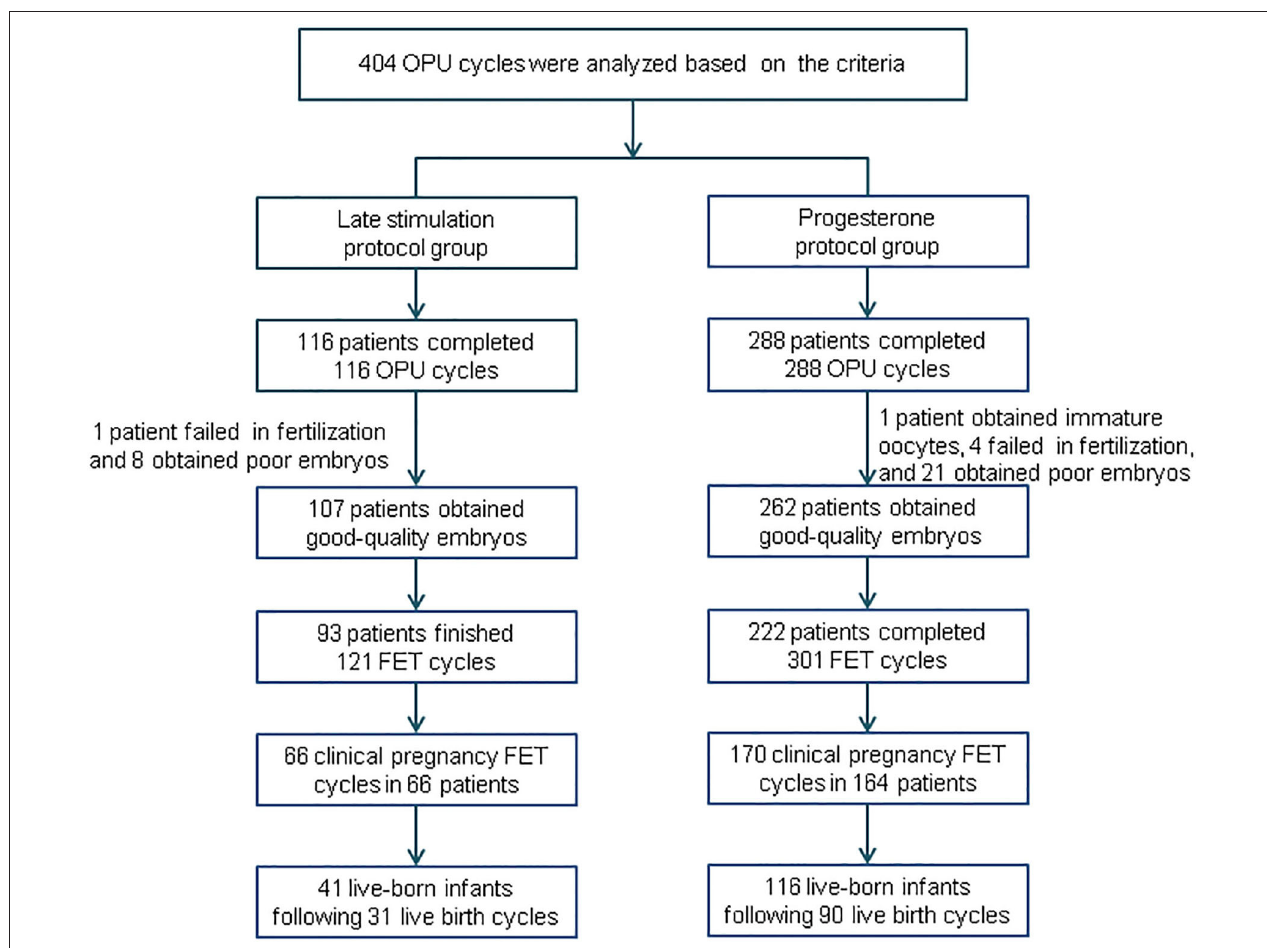
FIGURE 1 | Flowchart of this study. OPU, oocyte pick-up; FET, frozen-thawed embryo transfer.